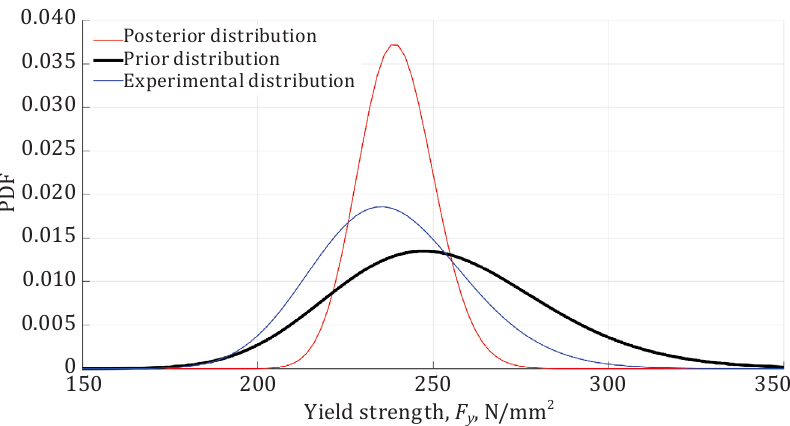
Figure 6. Prior, experimental and posterior distribution Yield